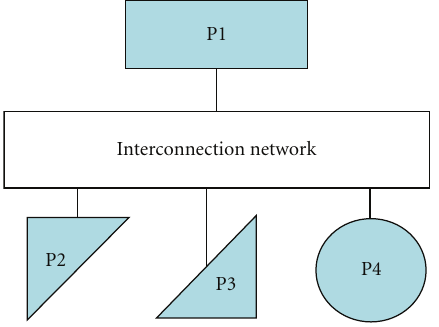
Figure 3: Homogeneous multiprocessor systems.